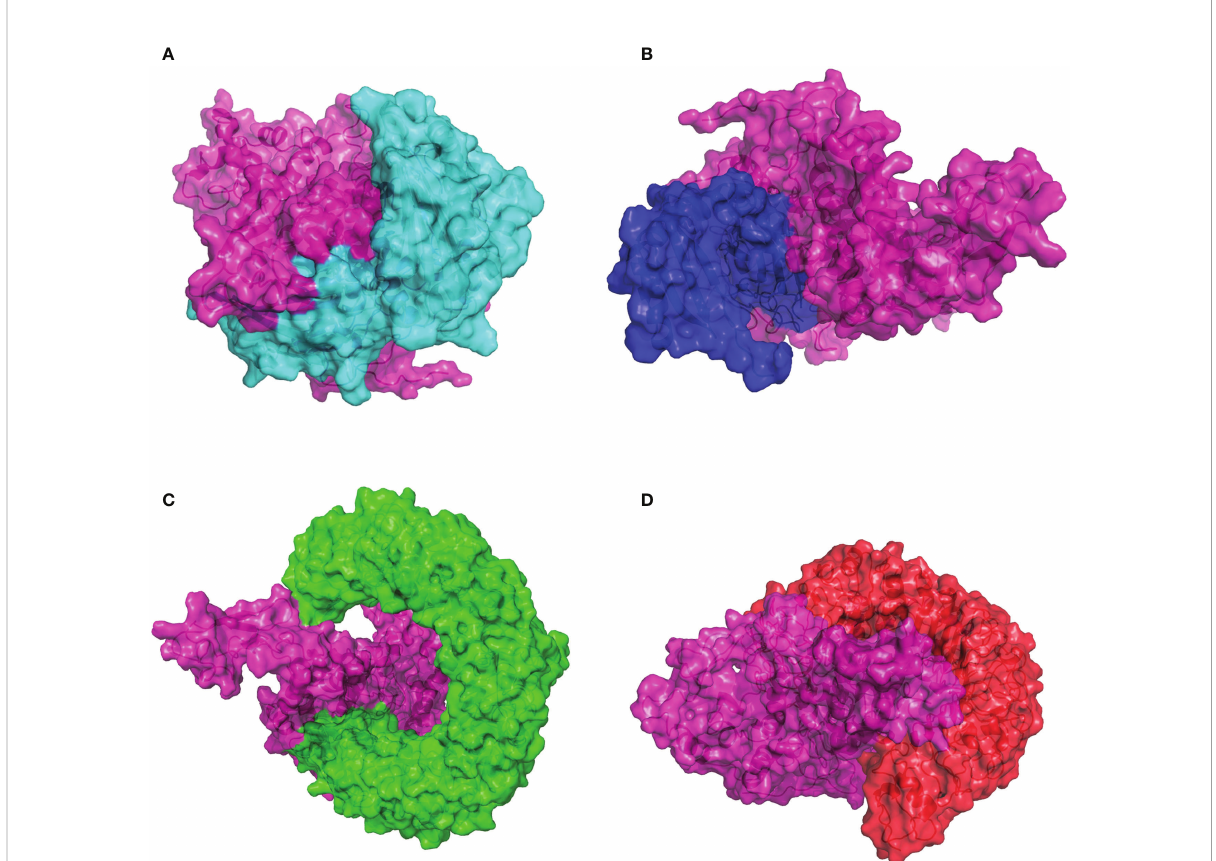
FIGURE 5 Molecular docking of the CVB vaccine (pink color) with human immune receptors. (A) CVB vaccine and MHC-I. (B) CVB vaccine and MHC-II. (C) CVB vaccine and TLR3. (D) CVB vaccine and